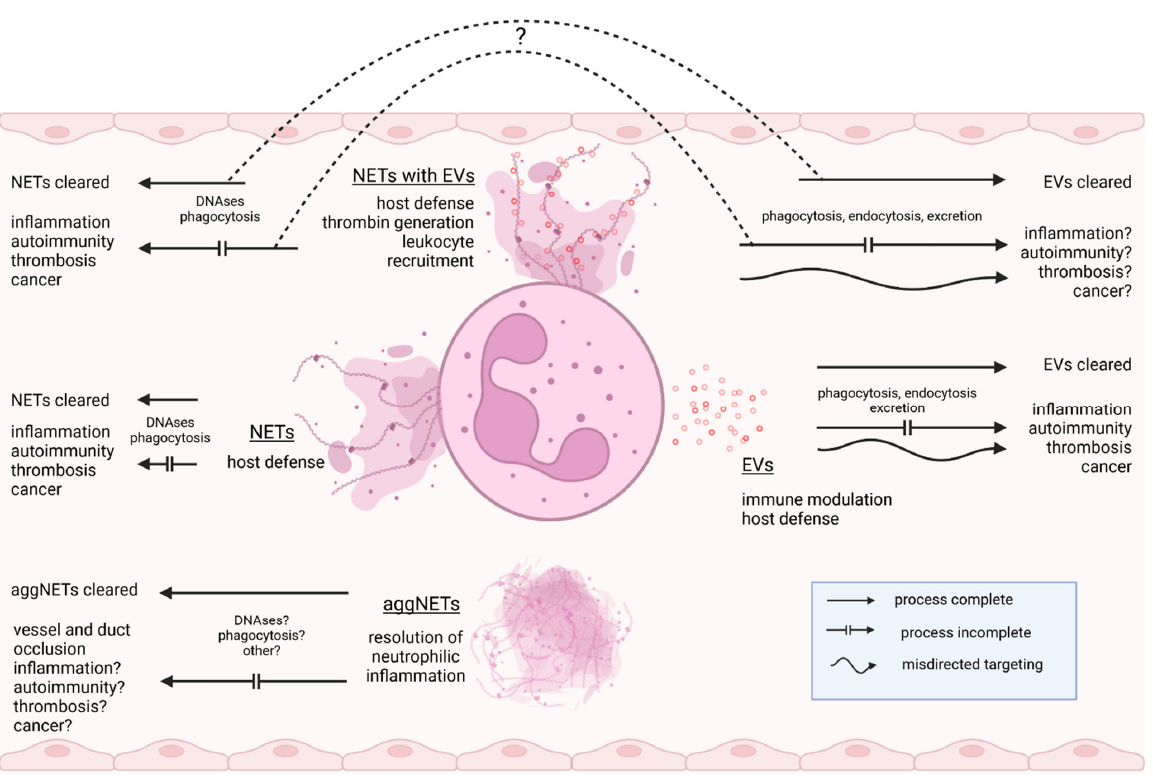
Figure 2. Dysregulated expression or impaired clearance of EVs (by phago-/endocytosis, excretion) and NETs (by DNase-digestion, phagocytosis) may trigger various pathologies. Binding of EVs to NETs may hypothetically lead to a reciprocal influence on EV and NET clearance (dashed line). Created with